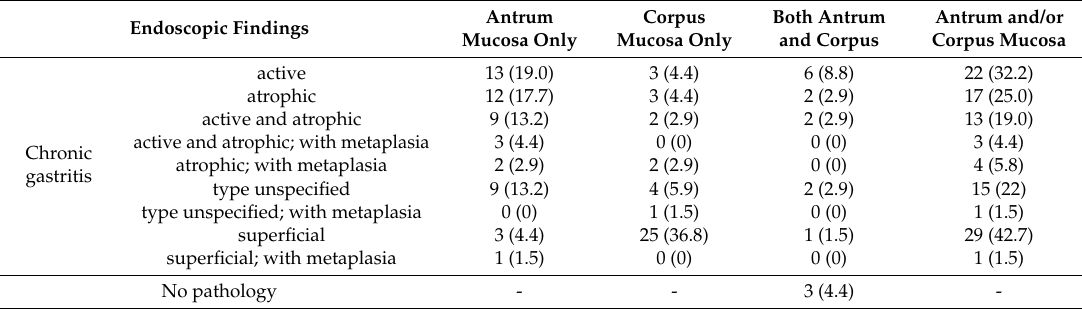
Table 2. Endoscopic findings in patients with obesity (number and